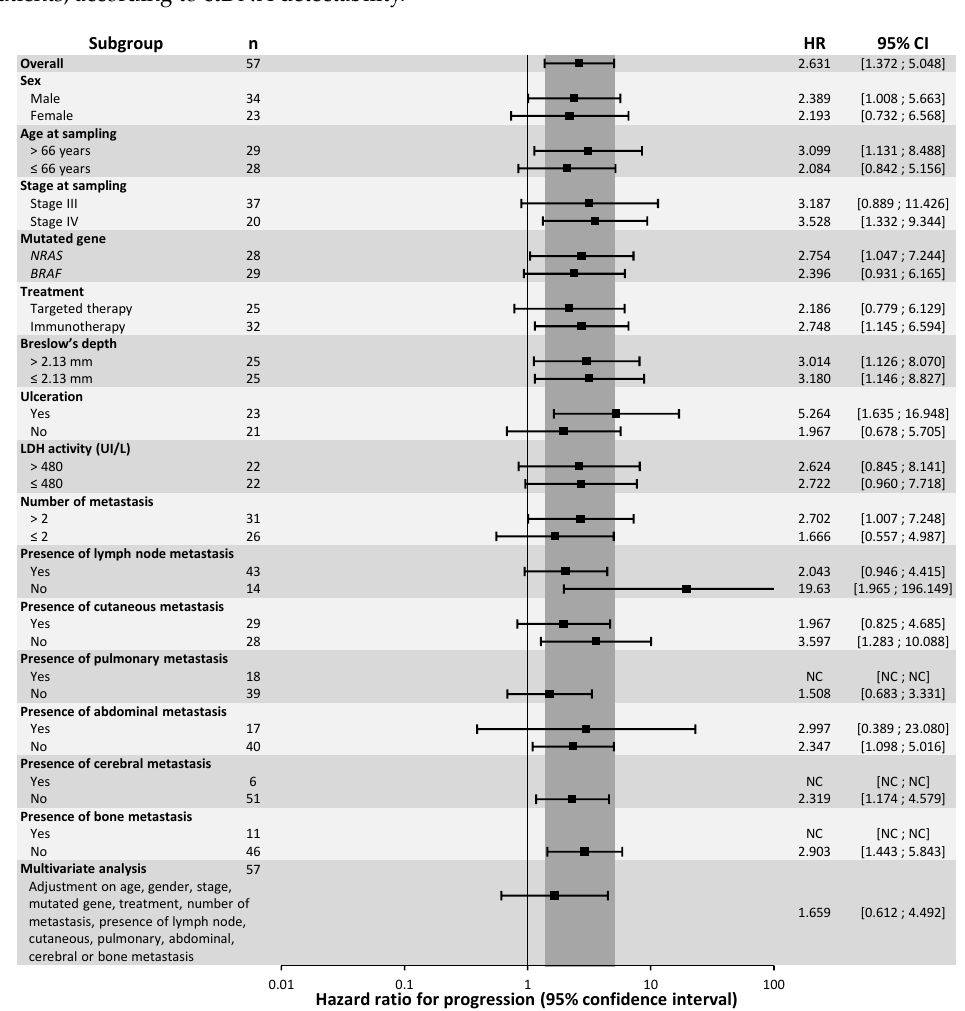
Figure 1. Kaplan–Meier estimates of Progression-Free Survival ( A ) and Overall Survival ( B ) of first-line patients, according to ctDNA detectability.